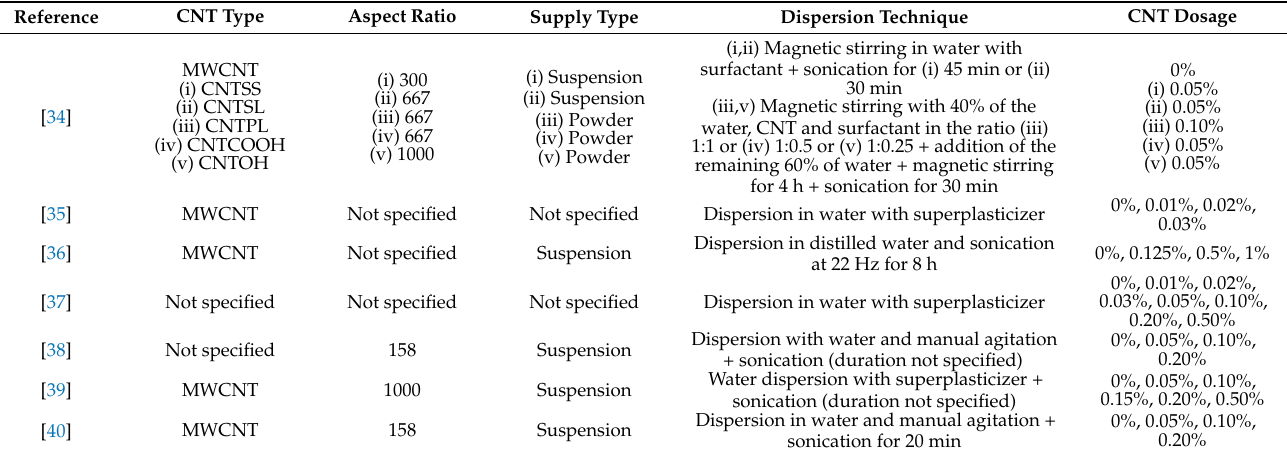
Table 2. Characteristics, dispersion techniques, and dosage of carbon